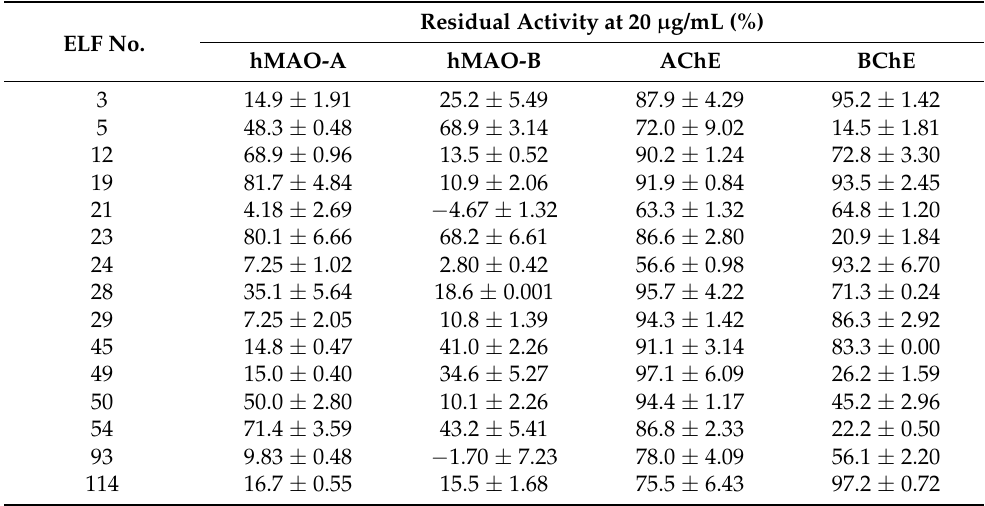
Table 1. Inhibitory activities of ELF extracts against hMAO-A, hMAO-B, AChE, and BChE. ELF No.